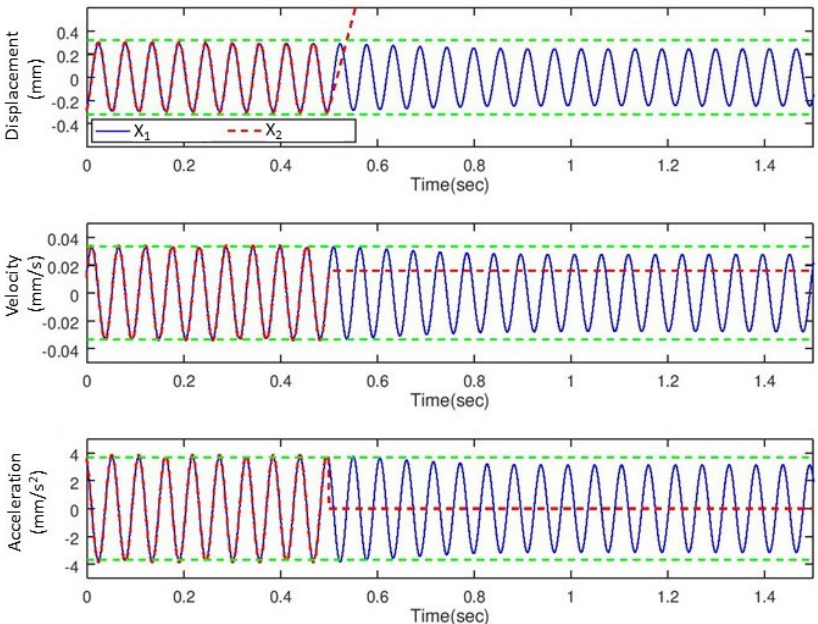
Figure 2. Response of two bodies before separation and after separation at 0.5 s.